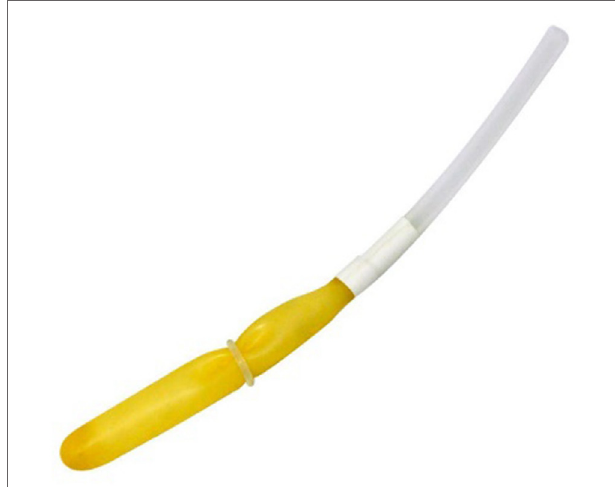
FIgURe 1 | Inflatable anal latex probe used with the Neurodyn Evolution biofeedback device (Ibramed, Amparo, Sao Paulo, Brazil).